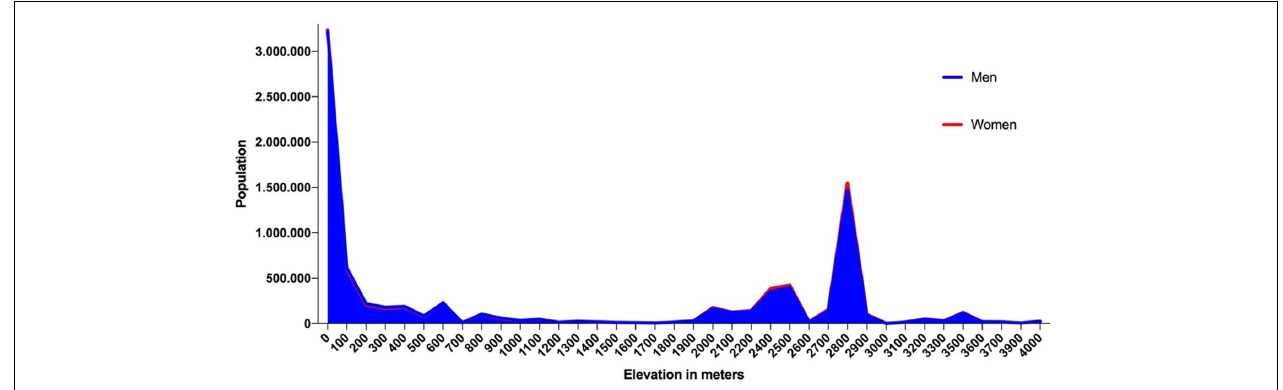
FIGURE 2 | Population by elevation in Ecuador by